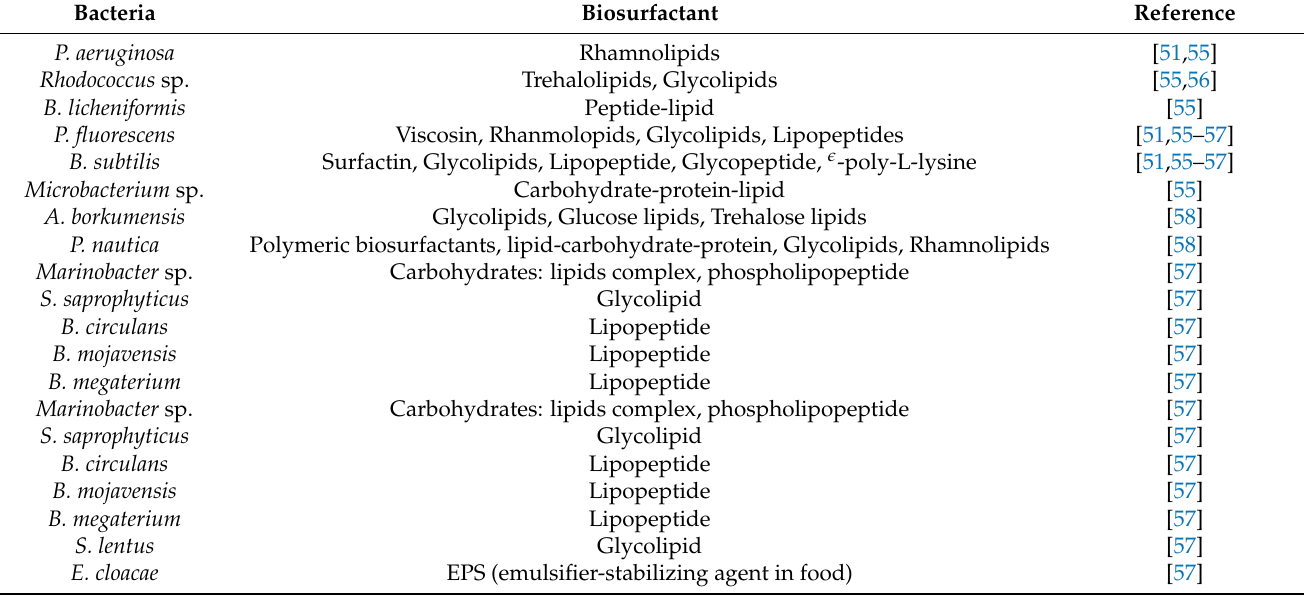
Table 2. Biosurfactants produced by hydrocarbon-degrading